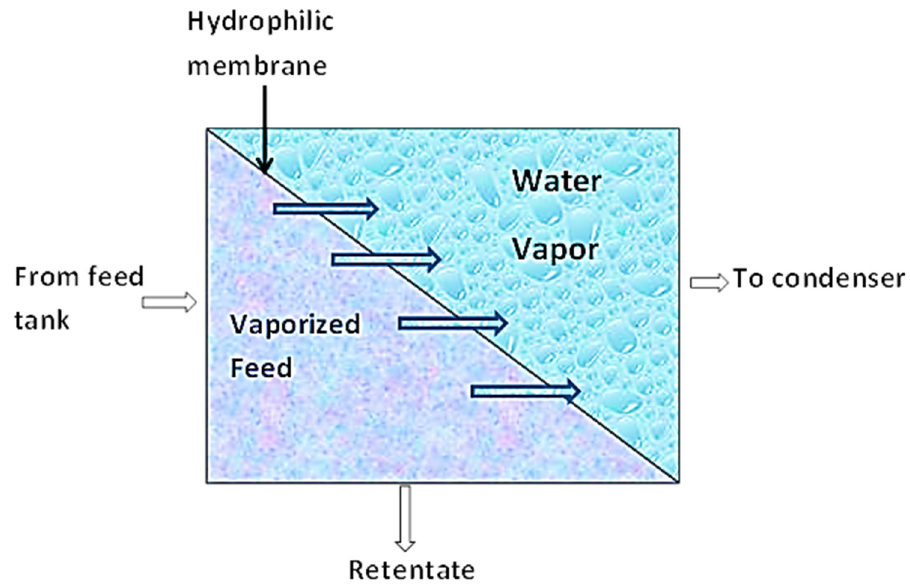
Figure 4. Schematic diagram of Pervaporation.